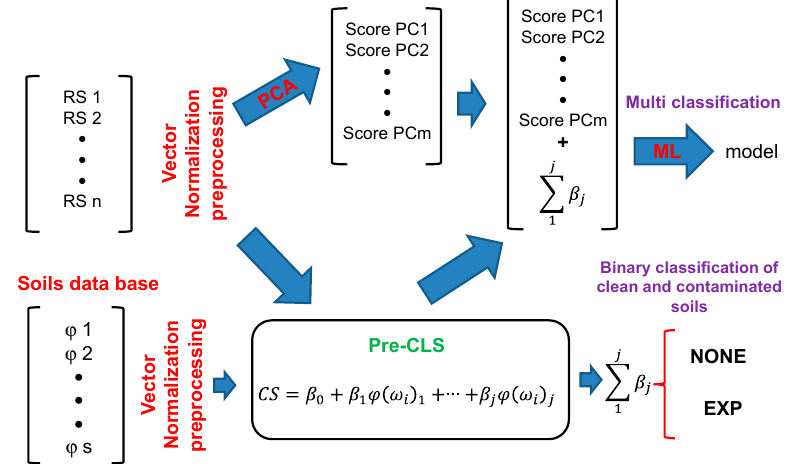
Figure 1. Machine learning pipeline for improving classification.